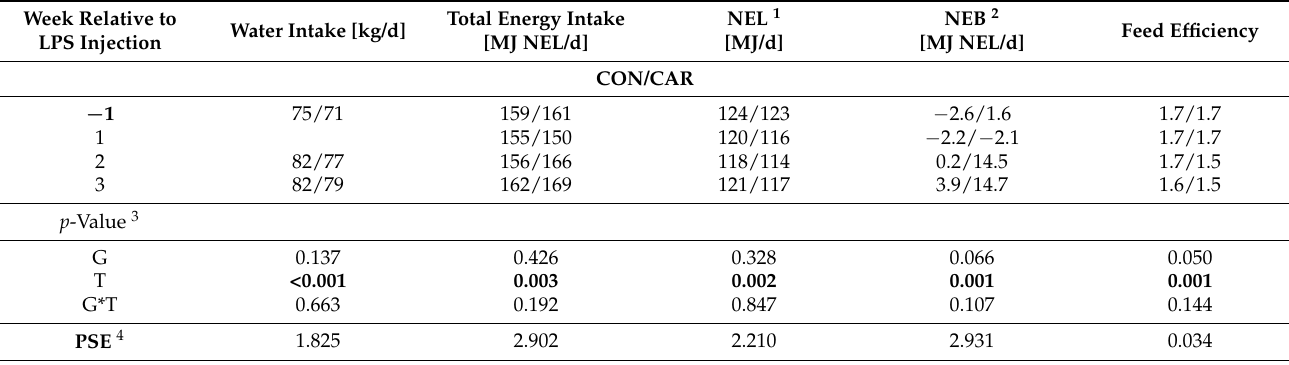
Table A2. Effects of an L -carnitine supplementation on water intake, total energy intake, net energy requirement for lactation (NEL), net energy balance (NEB) and feed efficiency of German Holstein cows challenged by an intravenous injection of lipopolysaccharides (LPS, 0.5 µ g/kg BW) at the first day in week